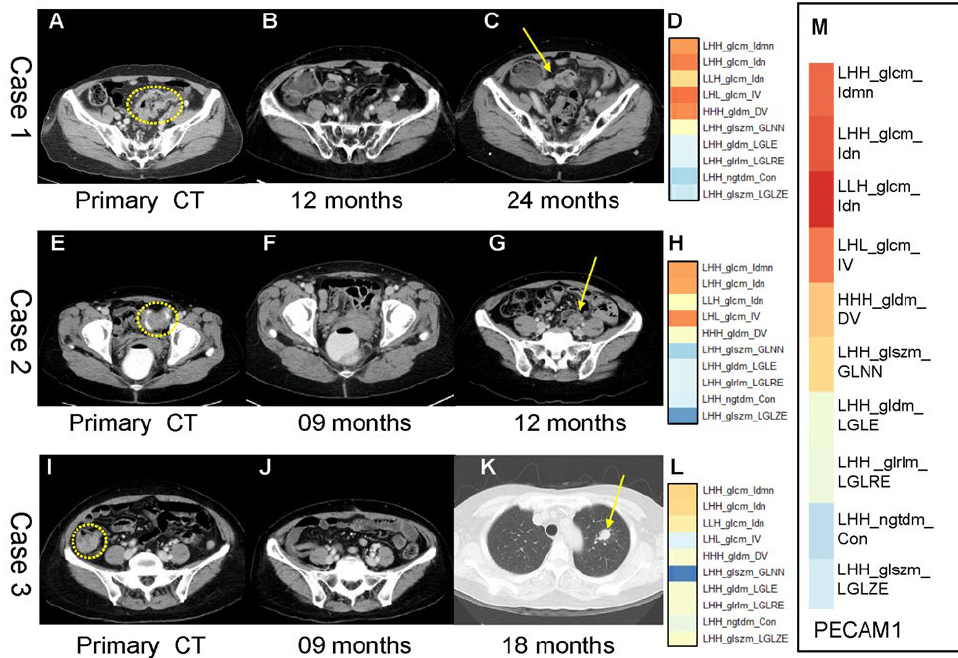
Figure 5. Treatment strategies by adjusted radiomic features in recurrent colorectal cancer. Three stage III CRC patients with individualized treatment targets identified by adjusted radiomic features. PECAM1 is indicated as the potential therapeutic target.